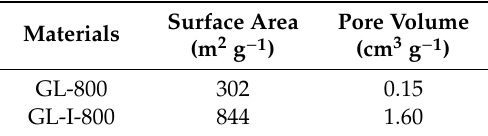
Figure 1. Scanning electron microscope (SEM) images of ( a , b ) GL-800 (glucose carbonized at 800 ◦ C) and ( c , d ) GL-I-800 (glucose carbonized with eutectic salt LiI / KI at 800 ◦ C). ( e , f ) Transmission electron microscope (TEM) images of GL-I-800. N 2 adsorption–desorption isotherm of ( g ) GL-800 and ( h ) GL-I-800 (inset image is pore size distribution). ( i ) X-ray di ff raction (XRD) patterns and ( j ) Raman spectra of GL-800 and GL-I-800. Table 1. The comparison of surface area and pore volume of GL-800 (glucose carbonized at 800 ◦ C) and GL-I-800 (glucose carbonized with eutectic salt LiI / KI at 800 ◦